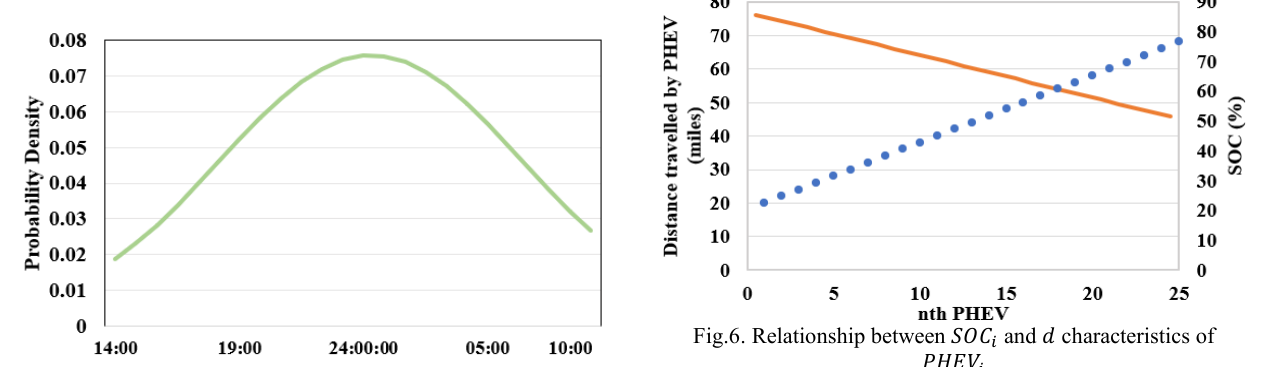
and characteristics of 𝑆𝑆𝑆𝑆𝐶𝐶 𝑔𝑔 𝑑𝑑 𝑃𝑃𝑃𝑃𝑃𝑃𝑉𝑉 𝑔𝑔 The load modelling of PHEV is done in two